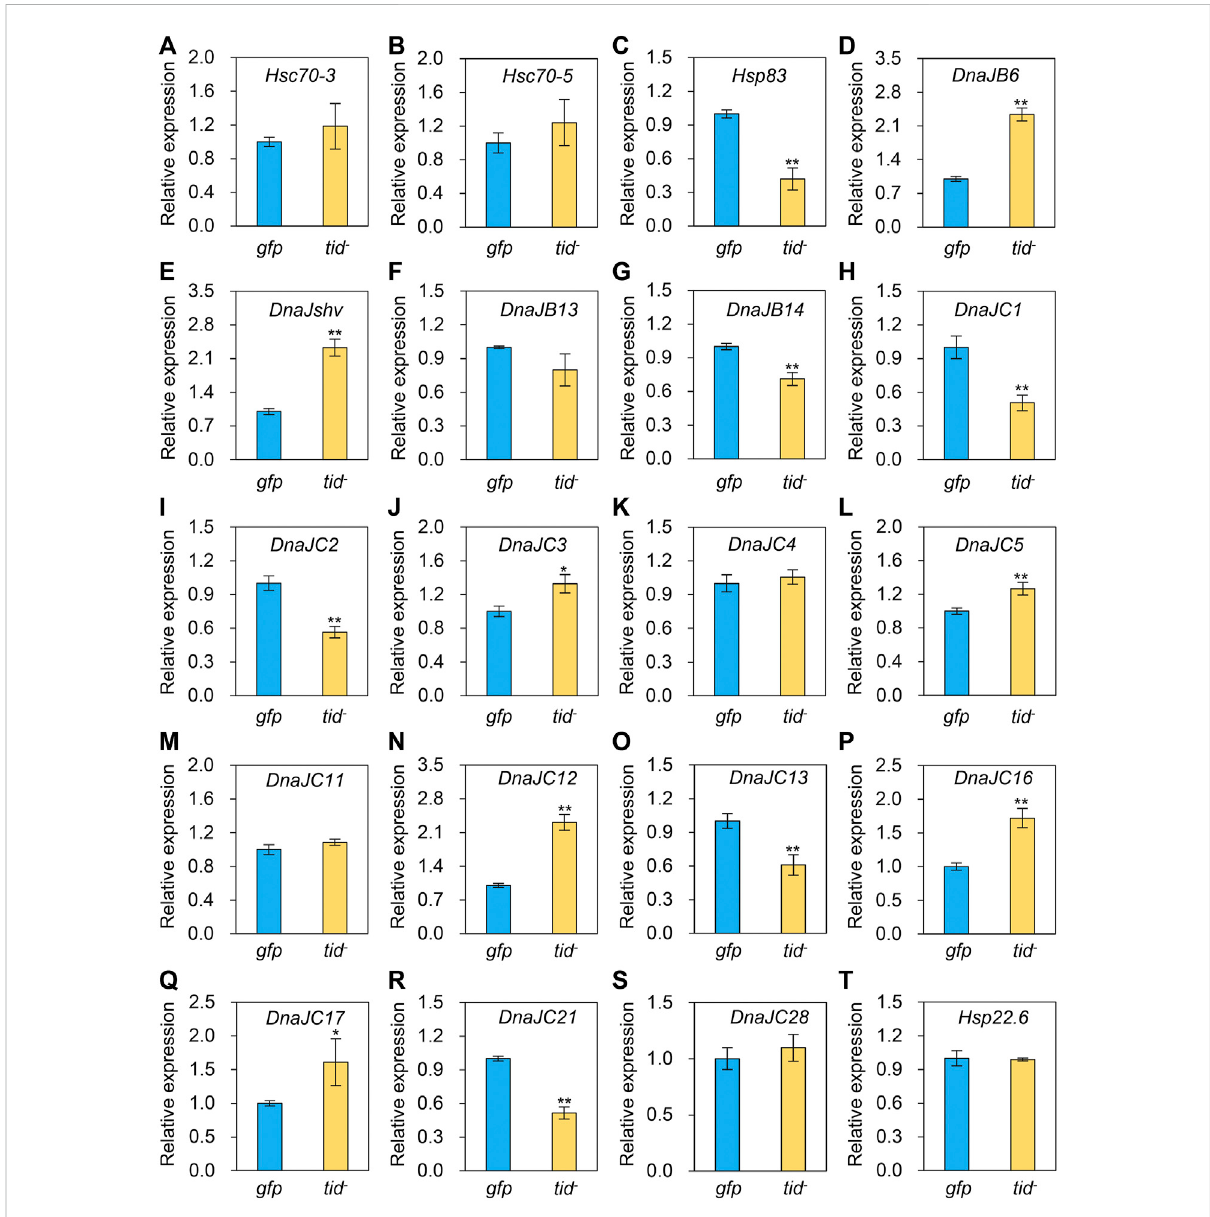
FIGURE 8 Impacts of AccTid knockdown on the mRNA levels of twenty Hsps (A – T) . gfp : GFP control. tid -: knockdown of AccTid . β -actin was used as an internal control. Signi fi cant differences between two groups are indicated by * p < .05 and ** p < .01 based on Student ’ s t